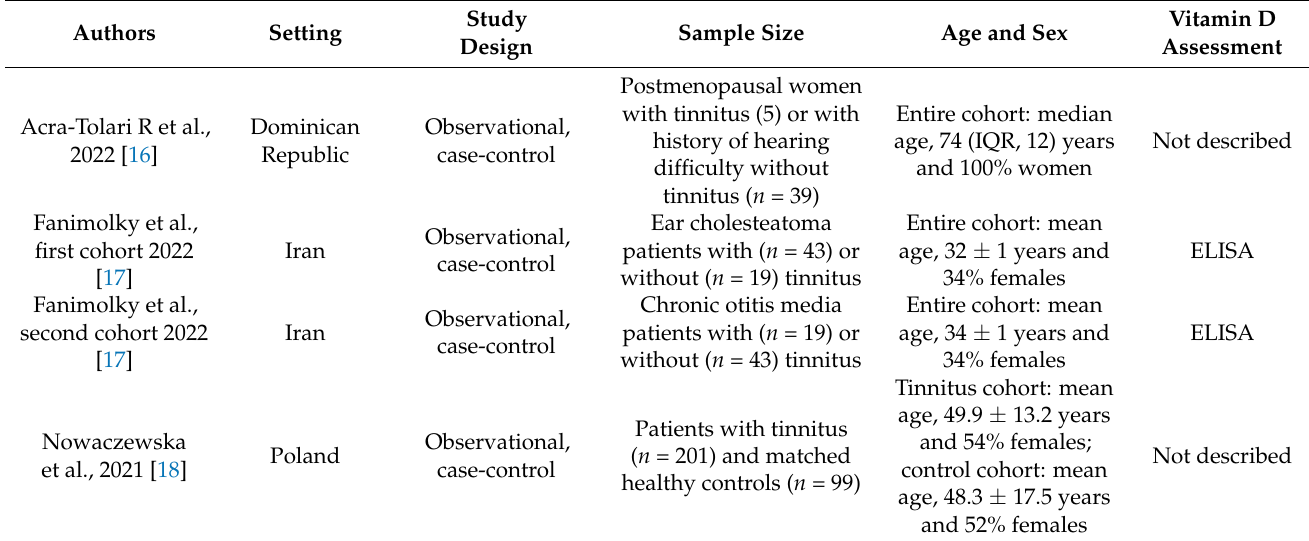
Table 1. Main characteristics of studies reporting serum vitamin D concentration in patients with or without